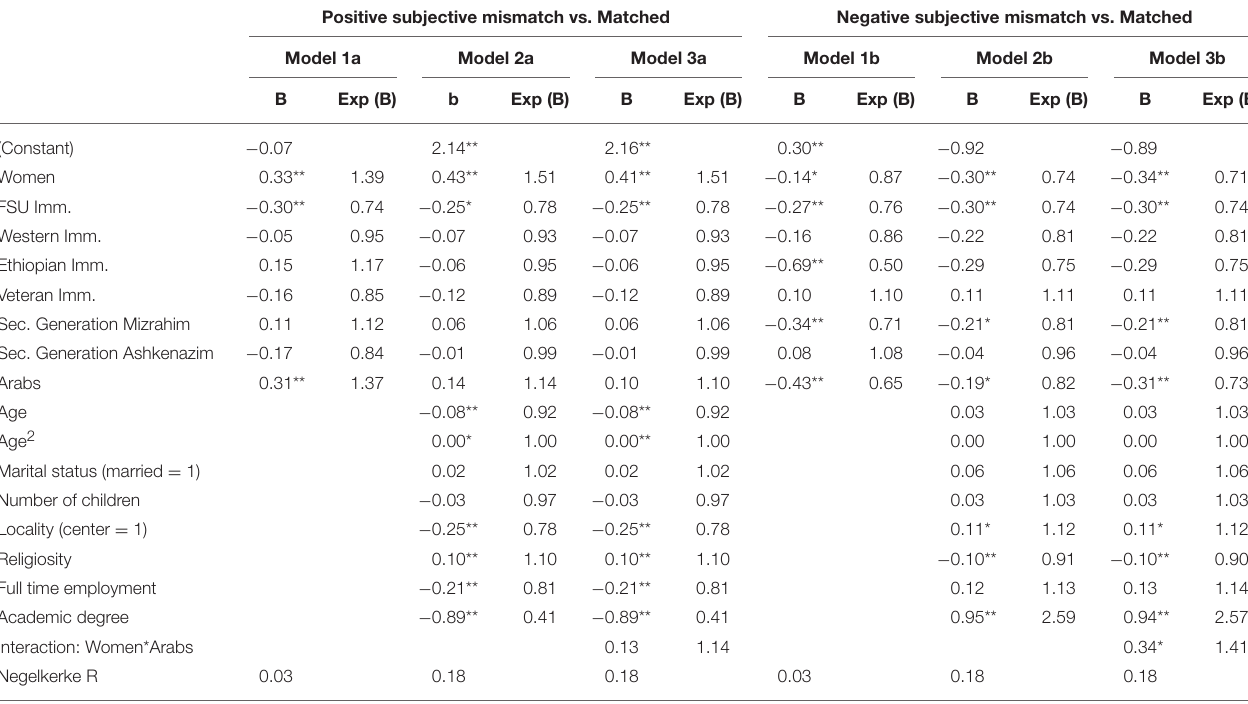
TABLE 3 | Multinomial regression analysis for Subjective mismatch in the labor market: comparison group is “Matched.” Positive subjective mismatch vs.